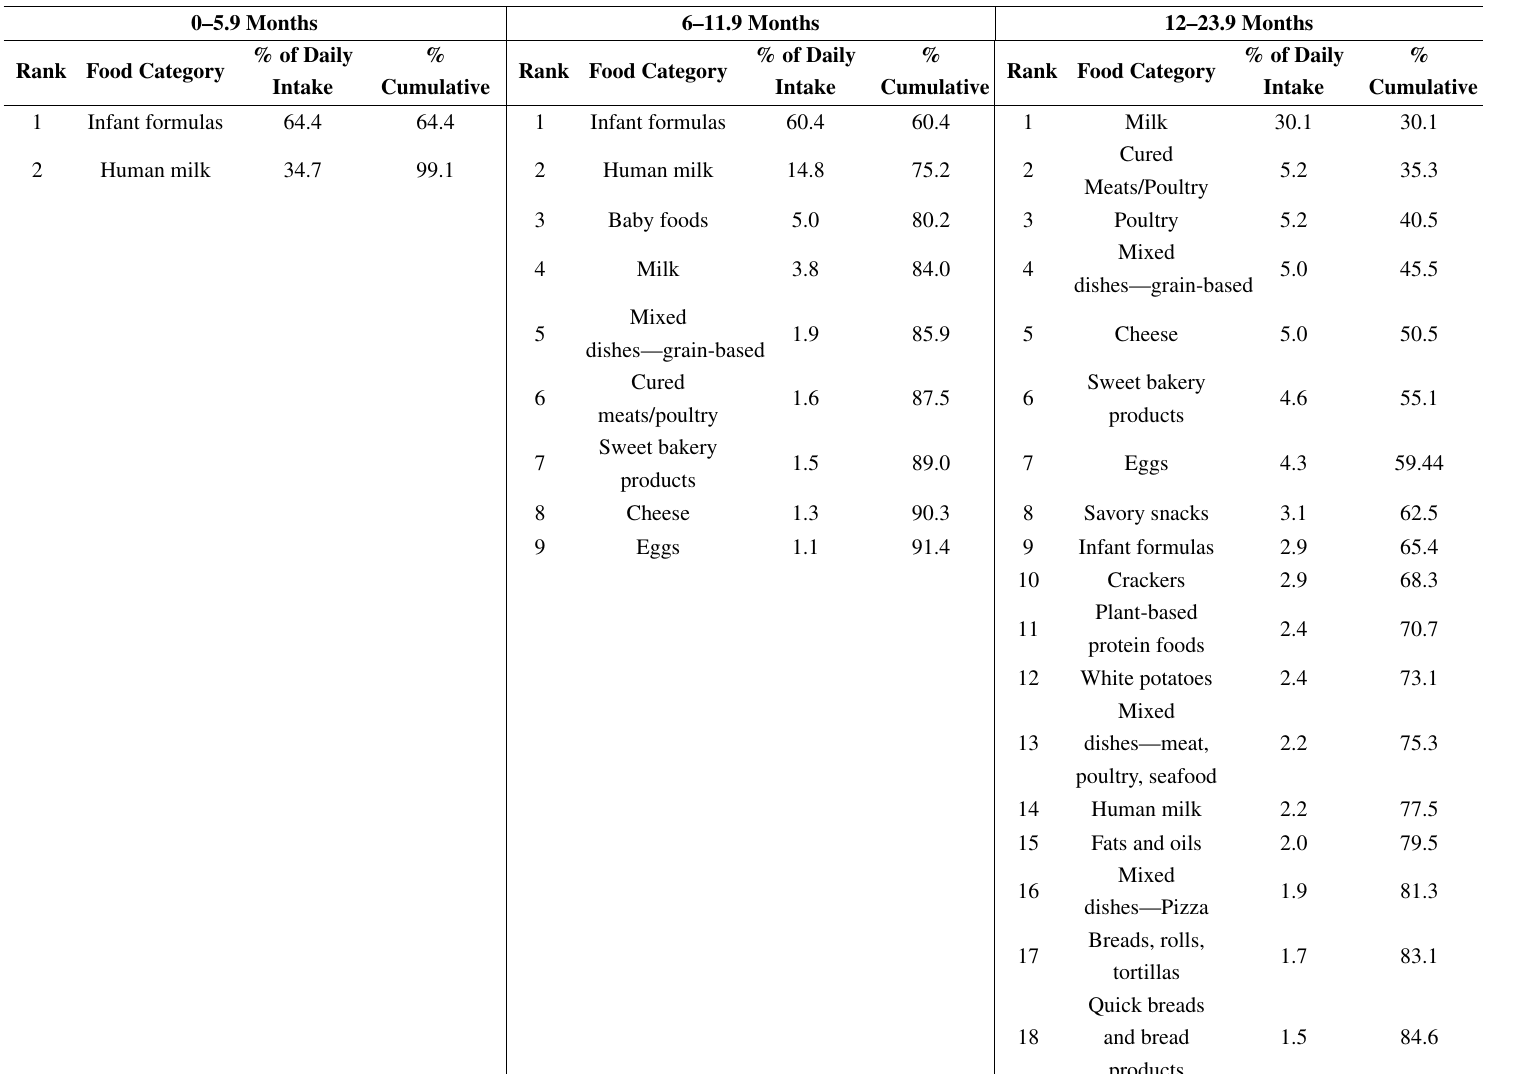
Table 4. Food sources of total fat among US infants and toddlers aged 0–23.9 months by age group: NHANES 2005–2012 ( n = 2740) a